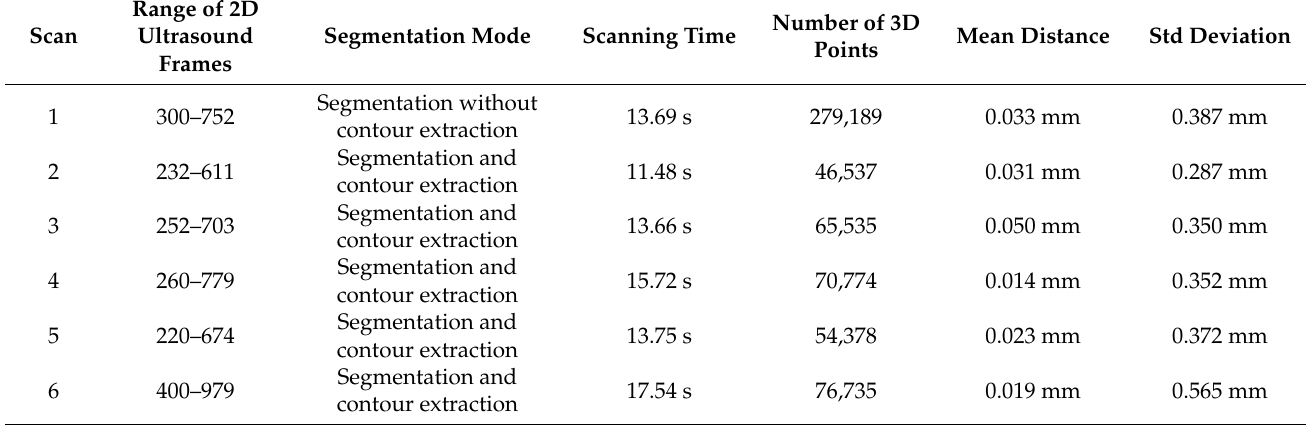
Table 1. Statistical analysis: mean distance and standard deviation for the 3D ultrasonographic point clouds of six consecutive scans of the same CAD/CAM manufactured object.